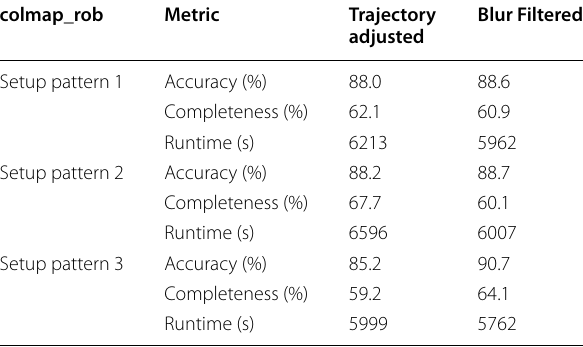
Table 7 Reconstruction performance comparison results by colmap_rob before and after blur filtering under three setup